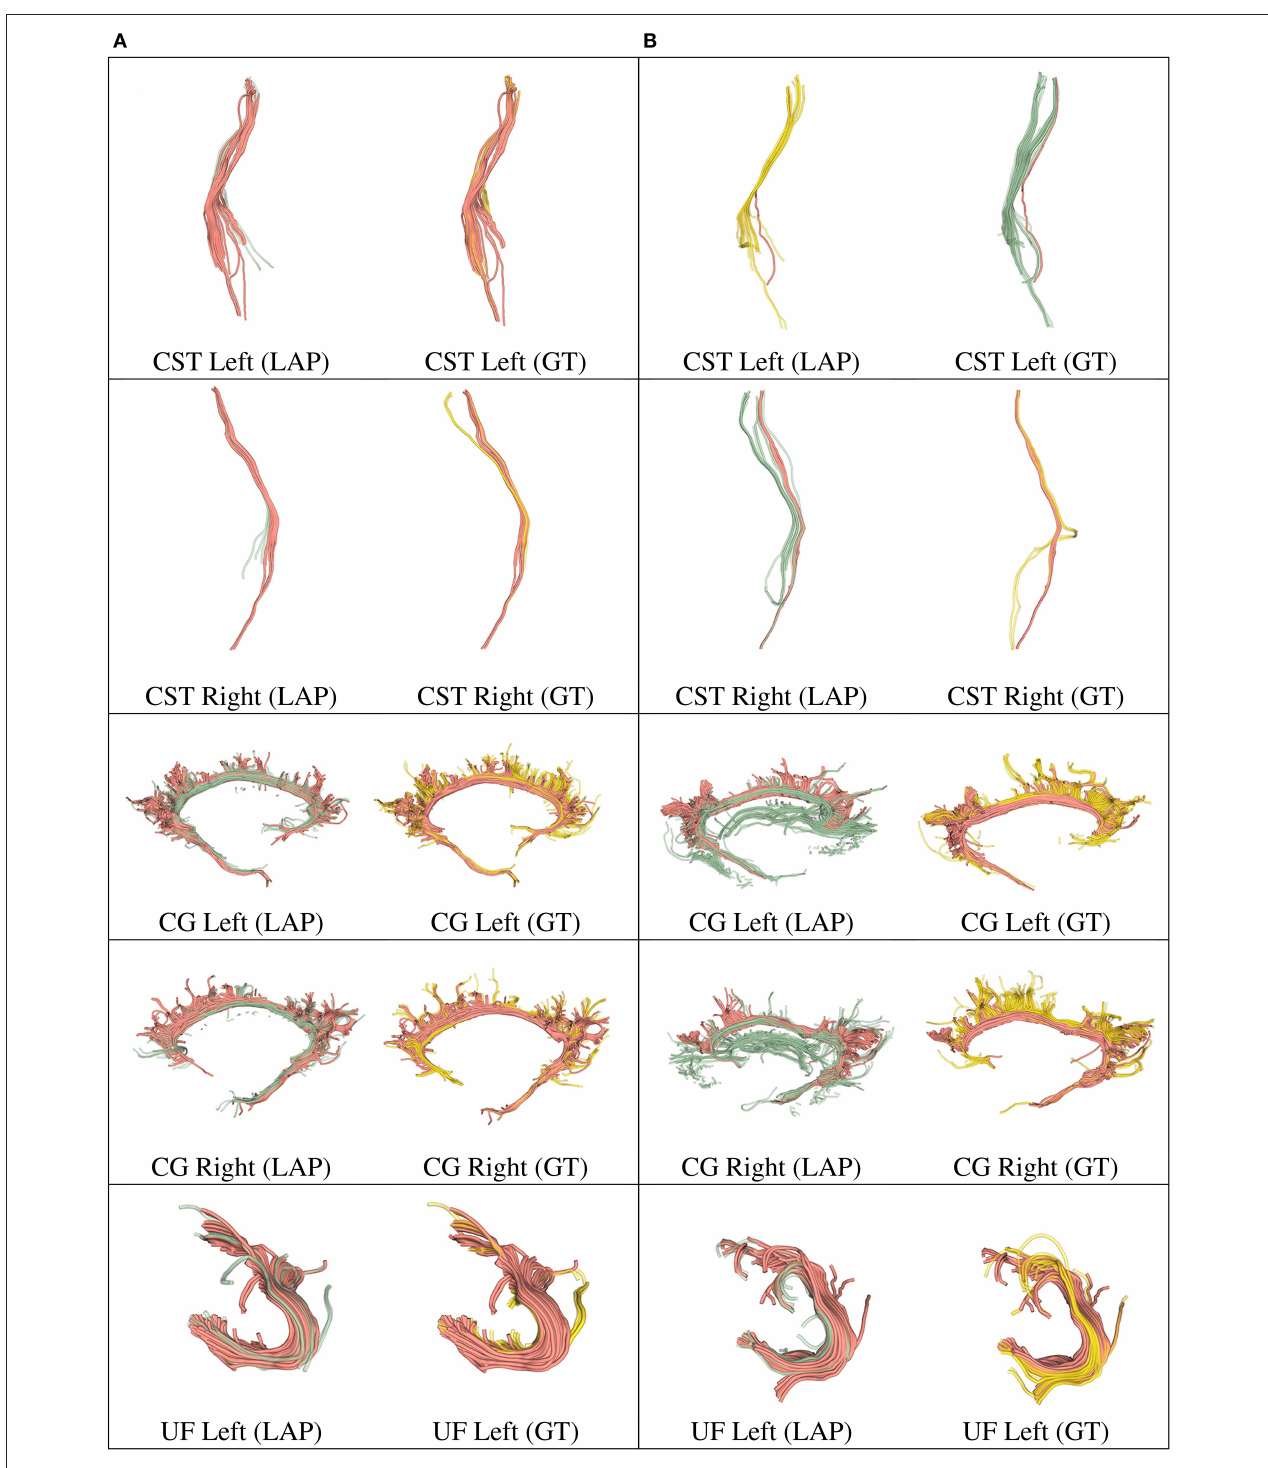
FIGURE 5 | In each row, in column (A) , we show the tract obtained with LAP-based segmentation (LAP) with highest DSC score among all test subjects, together with the related ground truth (GT). In column (B) , we show the one with lowest DSC score, together with the ground truth. The streamline of salmon color are TP, the ones in green are FP and the ones in yellow are FN. The tracts are: CST (left, right), CG (left, right) and UF (left).